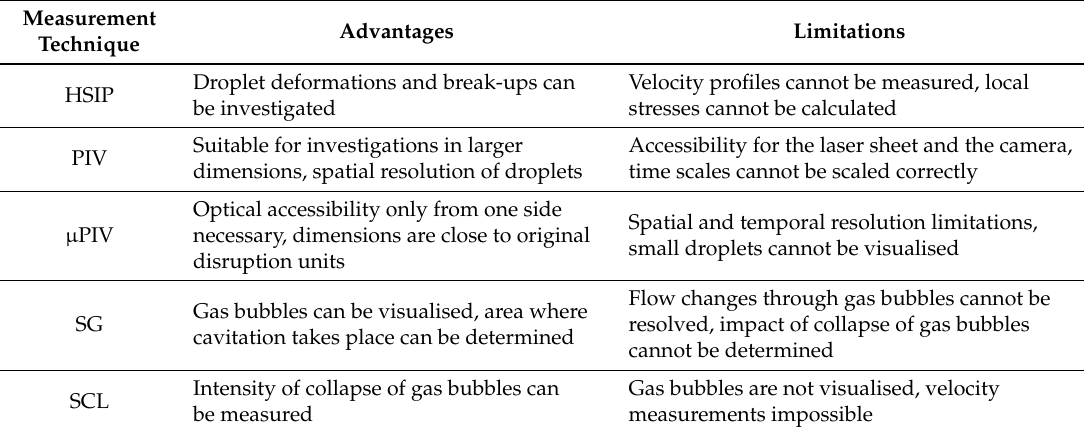
Table 2. Advantages and limitations of the presented measurement